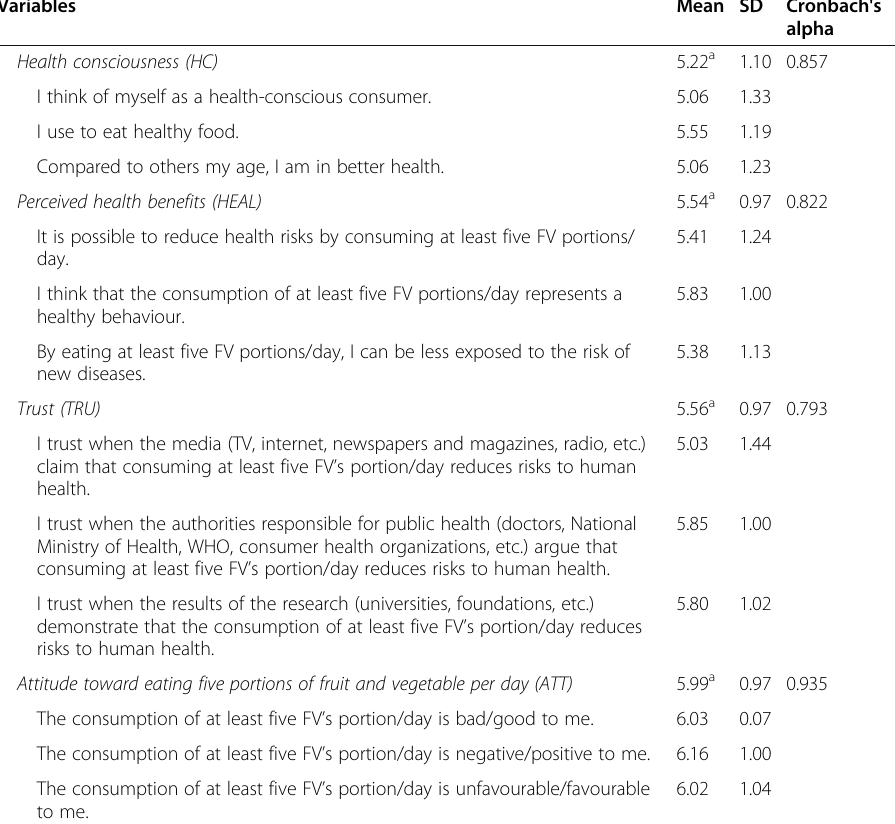
Table 3 Description of factors measured through Likert scales: health consciousness, perceived health benefits, and trust